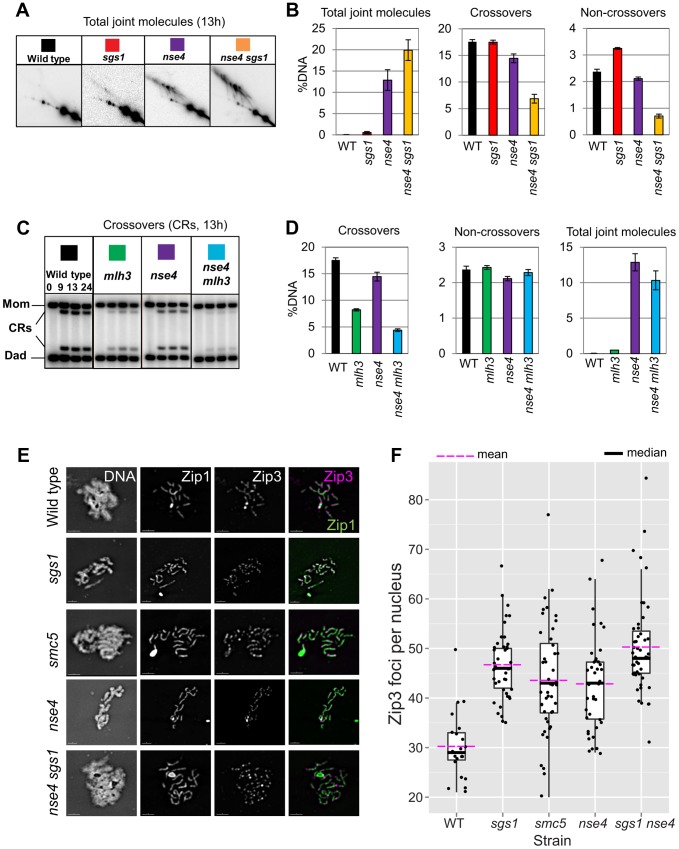
Sgs1 and MutLγ are functional in smc5/6.(A) Representative images of 2D analysis from sgs1 mutant (PCLB2-3HA-SGS1) in combination with nse4. (B) Quantification of total joint molecules, crossovers and non-crossovers, and total joint molecule levels at meiotic endpoints (13 hours). Quantification from three independent diploids; error bars represent the standard deviation. (C) Representative images of crossover formation in mlh3Δ mutants, in combination with nse4. (D) Quantification of crossovers, noncrossovers, and total joint molecules levels from three independent diploids (13 hours). (E,F) Analysis of Zip3 foci. Representative images and Tukey-Kramer box-and-whisker plot of 30 nuclei from each strain (boxes represent the 25th–75th percentile; the median value is denoted by the horizontal bar, and the whiskers are 1.5× the 25–75th percentile or max or min. values- whichever are the lowest). Fold increase in Zip3-GFP foci relative to wild type was calculated based on the arithmetic mean (horizontal bar, magenta). Note that the Zip3-GFP causes some polycomplex formation of Zip1 predominantly in the mutants but also in the wild type. The distributions of all four mutant strains were significantly different from wild type (p<0.01, Kruskall-Wallace). Strains: WT (Y1435), sgs1 (Y3591), smc5 (Y3514), nse4 (Y3511), sgs1 nse4 (Y3636).